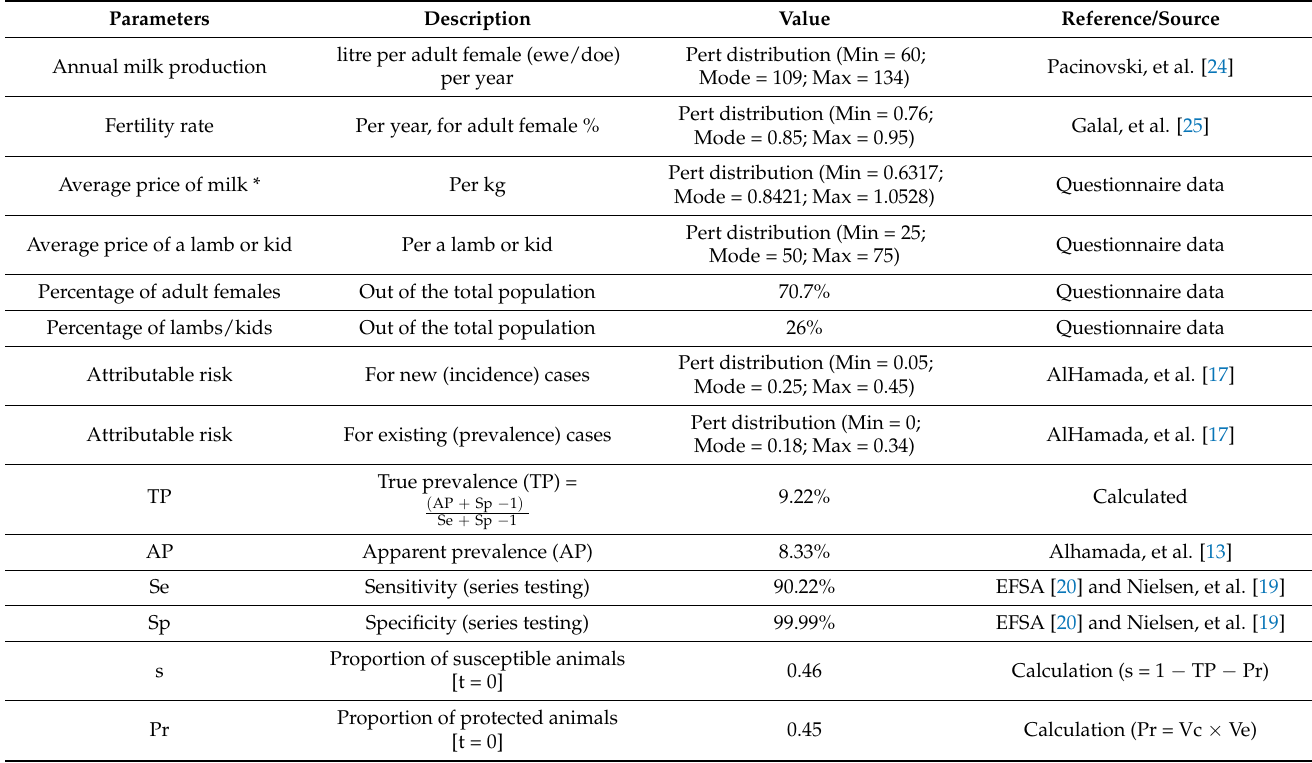
Table 1. Input parameters included in the cost–benefit analysis model comparing two different vaccination strategies to control brucellosis in sheep and goats in Dohuk, northern